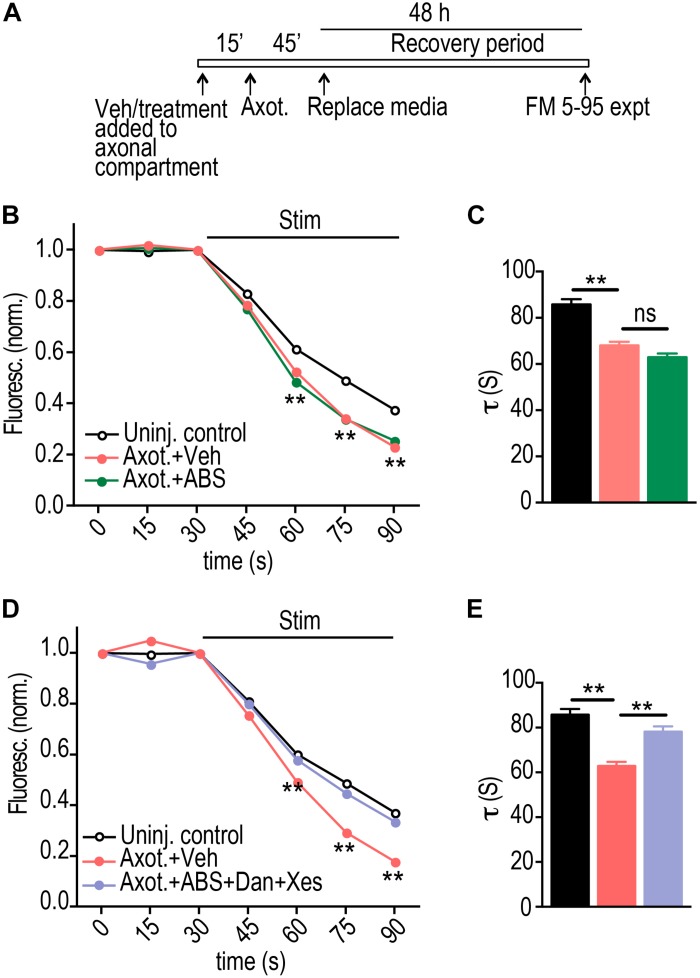
ER calcium channel activation at the site of injury is required for retrograde presynaptic hyper-excitability. (A) Experimental timeline for treatment and imaging within microfluidic chambers. (B) FM unloading curves at 48 h following application of vehicle or local activity blockade solution (ABS) to axons for 1 h during axotomy. Uninjured control: n = 1135 puncta; Axot. + Veh.: n = 1834 puncta; Axot. + ABS: n = 1590 puncta; 8 chambers per condition over 4 experiments. Two-way ANOVA, Bonferroni post hoc test. (C) FM decay time constant (τ) for puncta with τ < 360 s (Uninj. control: n = 1044; Axot. + Veh: n = 1686; Axot. + ABS: n = 1478). Unpaired two-tailed t-test. Each condition includes 8 chambers over 4 experiments. (D) FM unloading 48 h after application of vehicle or ABS supplemented with ryanodine receptor blocker (Dantrolene, 20 μM) and IP3 receptor blocker (Xestospongin C, 1 μM) to the axonal compartment. Uninjured control: n = 974 puncta; Axot. + Veh: n = 1239 puncta; Axot. ABS + Dan + Xes: 1124 puncta; 5 to 6 chambers per condition over 3 experiments. Two-way ANOVA, Bonferroni post hoc test. (E) FM decay time constant (τ) for puncta (Uninj. control: n = 892; Axot. + Veh: n = 1128; Axot. ABS + Dan + Xes: n = 1025). Unpaired two-tailed t-test. Each condition includes 5–6 chambers over 3 experiments. ∗∗p < 0.001. Error bars, s.e.m.